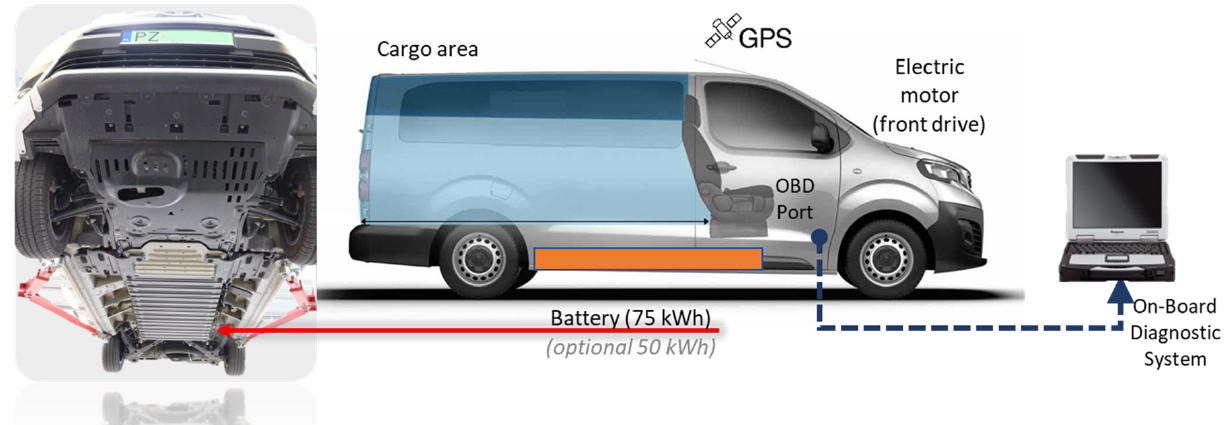
Figure 8. Schematic of the measurement system including a view of the location of the traction battery [32].